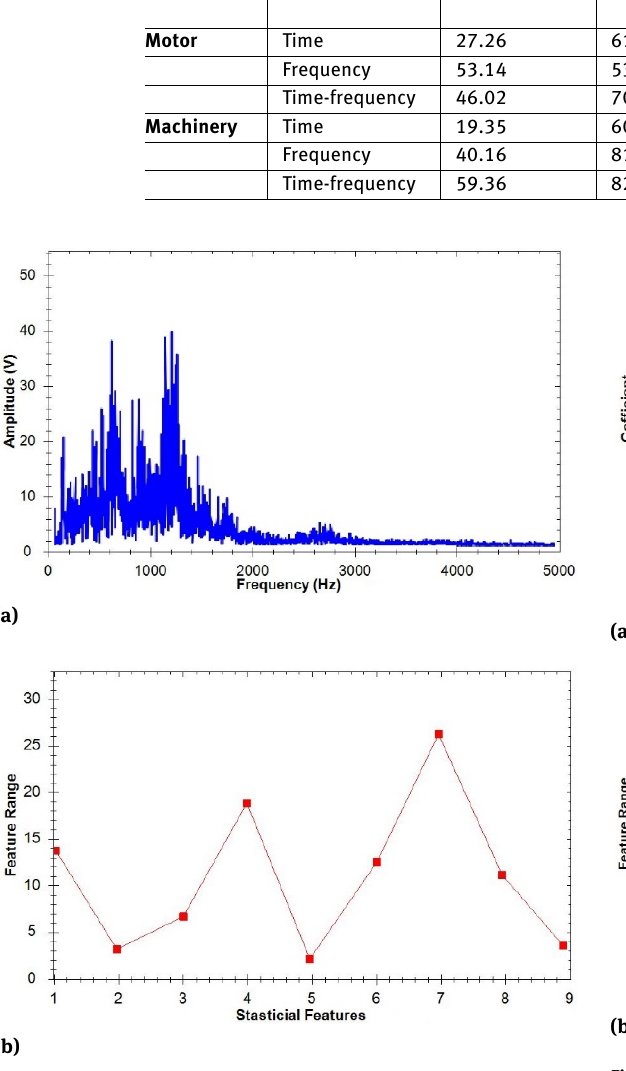
Figure 6: Feature analysis in frequency domain for fault diagnosis: (a) waveform in frequency domain of the first signal; (b) statistical features of first signal in frequency domain